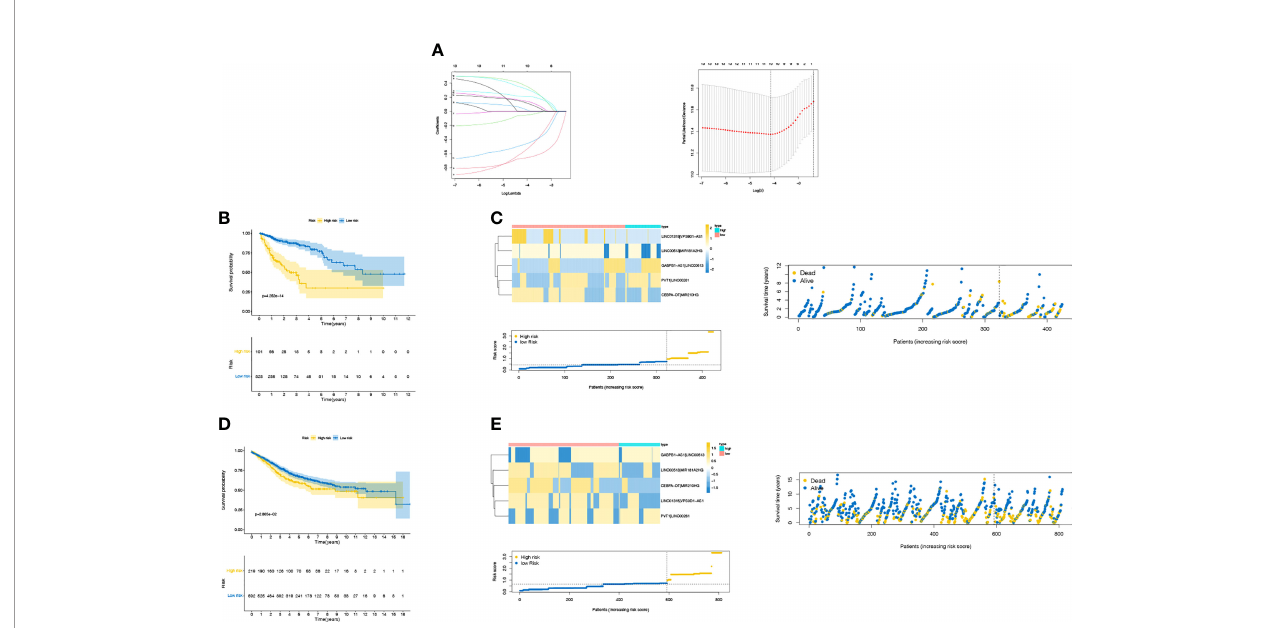
FIGURE 3 | (A) LASSO Cox regression analysis. Kaplan — Meier (KM) curve for overall survival (OS) of COAD patients in different risk group, risk survival status plot in TCGA cohort (B, C) and GEO cohort (D, E)